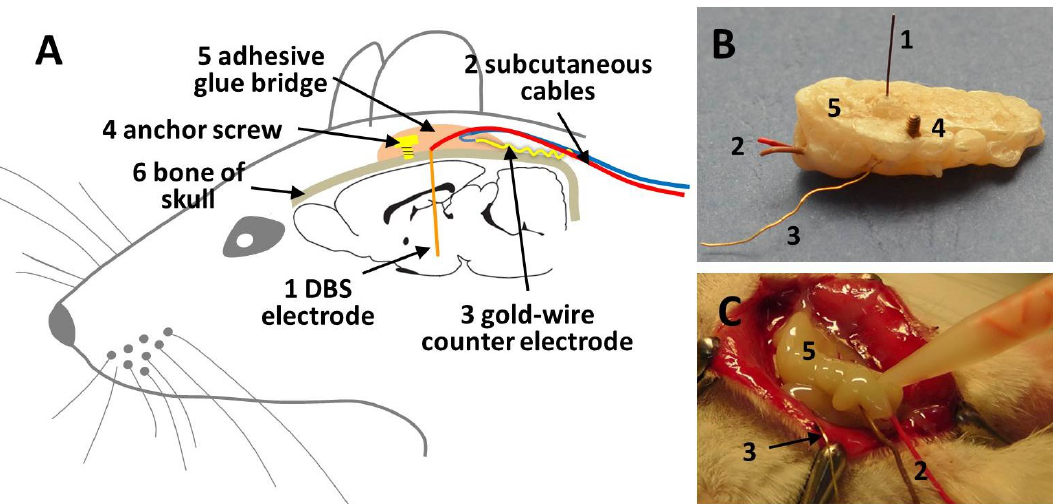
Figure 4: Implanted unipolar DBS electrode with gold-wire counter electrode. (A) Scheme of a sectional plane through the scull with: (1) unipolar Pt/Ir electrode, (2) connecting cables of stimulating and counter electrode, (3) gold-wire counter electrode, and (4) anchor-screw that was tightened to the skull on the left hemisphere. All components were embedded in an adhesive-glue bridge of biocompatible dental acrylic (5) that fixed the mounting to the skull. (B) Explanted DBS mounting. (C) Details of the surgical treatment. The operational area is spread by surgical clips. The connecting cables of the stimulating and counter electrodes are covered with biocompatible dental acrylic.